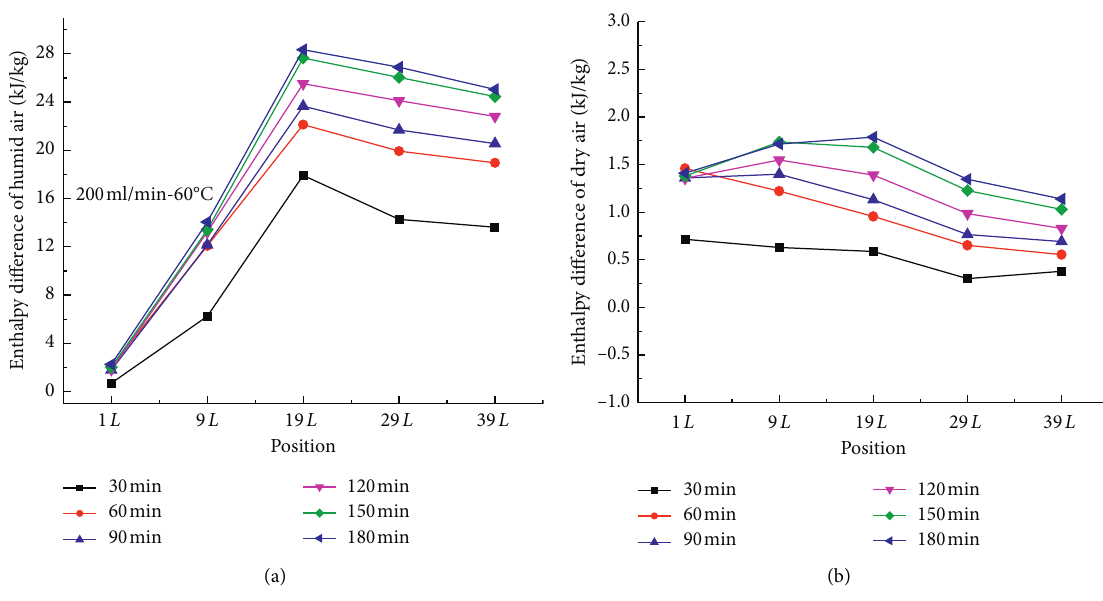
Figure 10: Analysis of the enthalpy difference variations at 19 L -39 L under the condition of